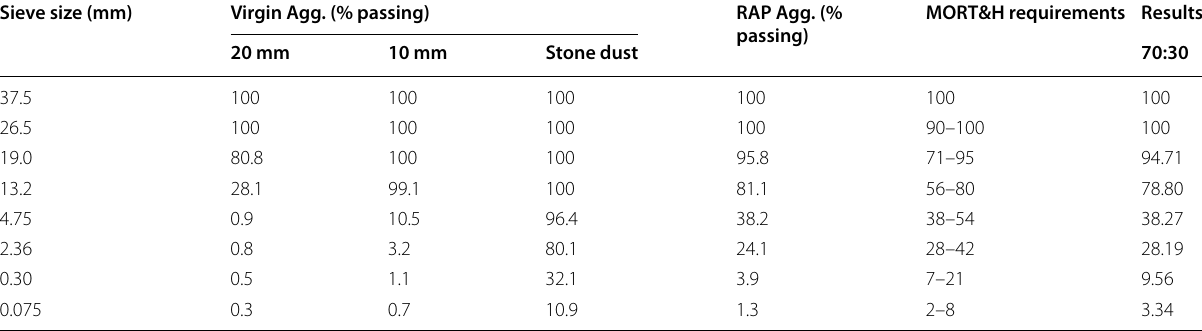
Table 4 Gradation of fresh and reclaimed aggregates for DBM Sieve size (mm) Virgin Agg. (% passing)